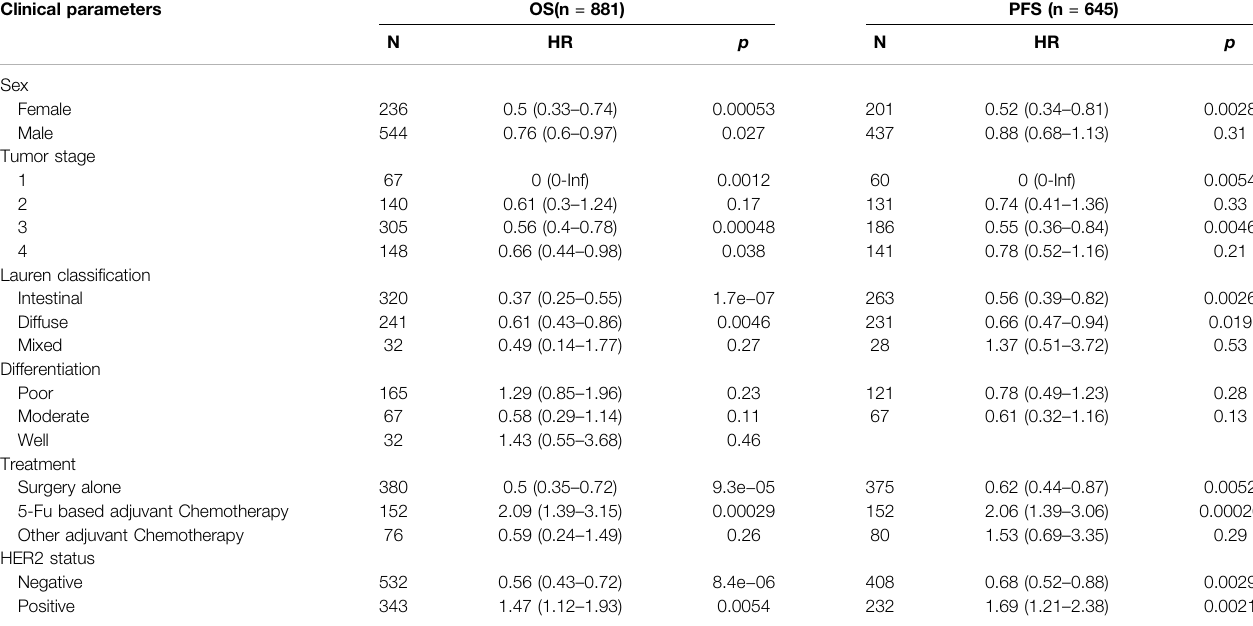
TABLE 1 | Correlation of ARHGAP11A and clinical parameters in gastric cancer from Kaplan-Meier Plotter. Clinical